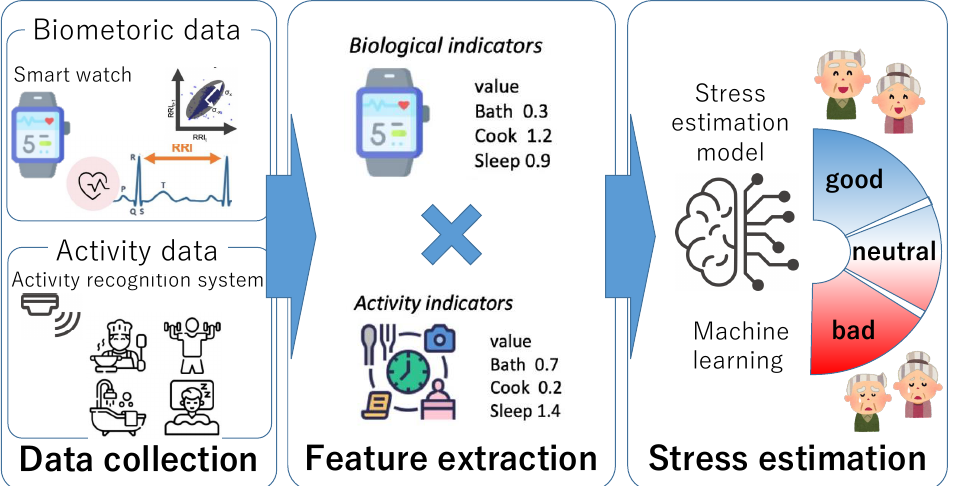
Figure 1. Overview of the proposed